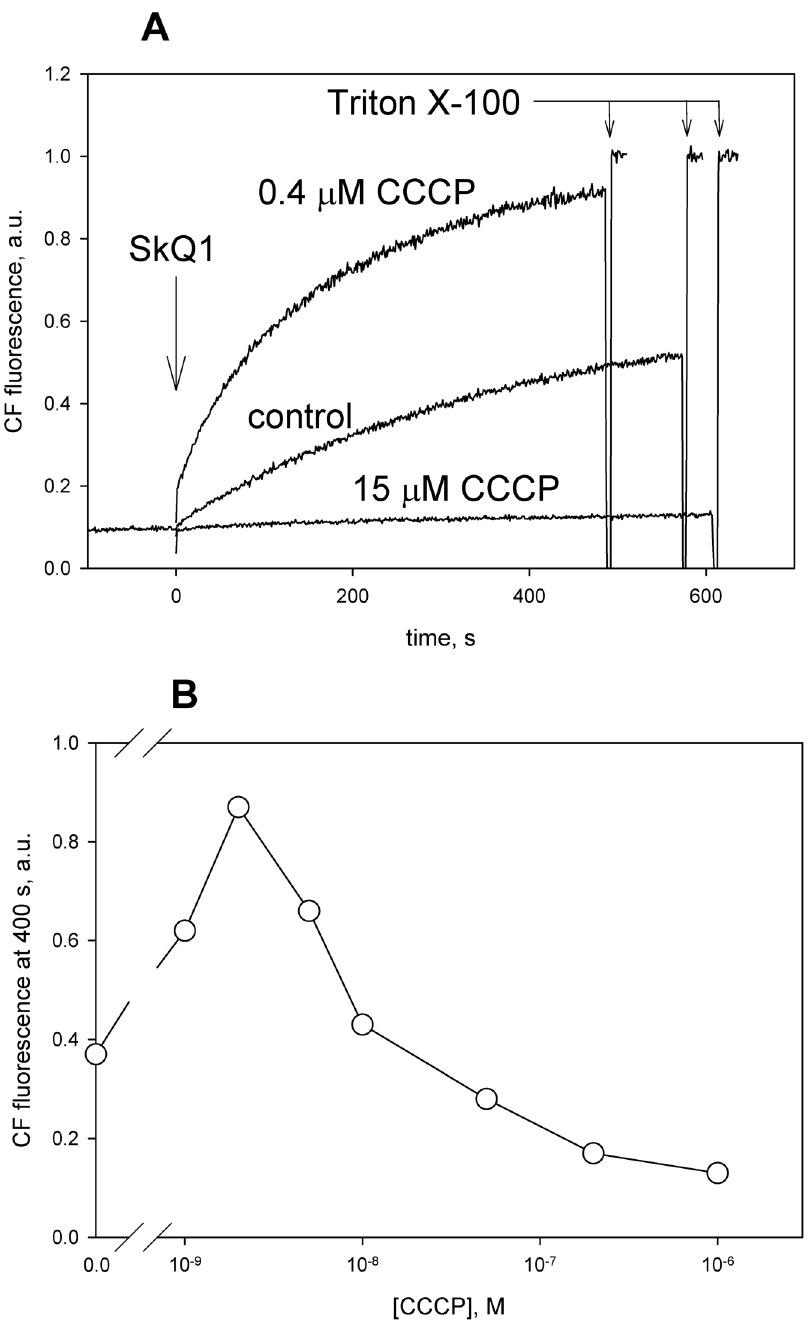
Figure 5. CCCP increases the SkQ-induced efflux of carboxyfluorescein from liposomes. Carboxyfluorescein (CF) efflux from DPhPC (diphytanoylphosphatidylcholine) liposomes (50 m g/ml), induced by 2.5 m M SkQ1 (panel A) or by 0.5 m M SkQR1 (panel B) was measured with or without CCCP. The efflux was accompanied by an increase in CF fluorescence due to dilution and a relief of CF self-quenching. In panel B, the CF efflux was measured 400 s after the addition of SkQR1. Incubation mixture, 10 mM Tris, 10 mM MES, 100 mM KCl, pH 7.